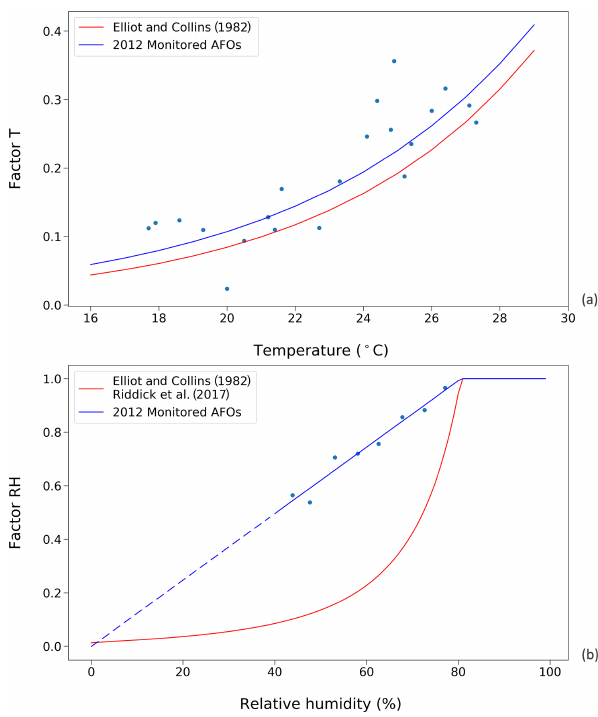
Figure 3. Factors affecting UA hydrolysis rate in chicken houses. Red curves represent the results from Elliott and Collins (1982). Blue curves represent results from this study, using data from the 2012 monitored animal feeding operations (AFOs; see Sect. 2.2.1). (a) Influence of temperature on UA hydrolysis. (b) Influence of rel- ative humidity (RH) on UA hydrolysis at optimum temperature con- dition ( ≥ 35 ◦ C). The dashed line is the extrapolation of factor RH as a function of RH due to a lack of data when relative humidity was below 40% in the AFO